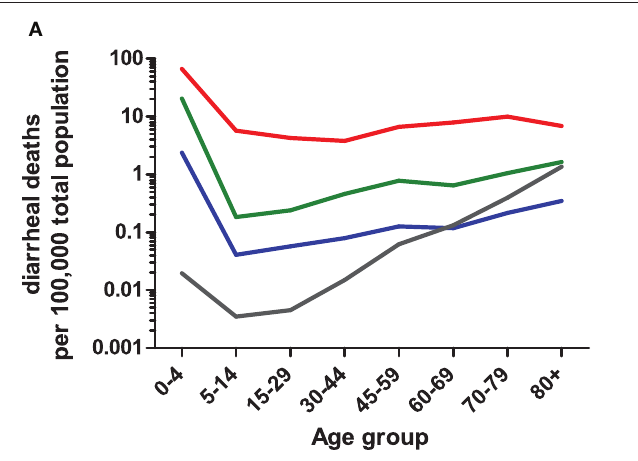
which ( n = 18) are classified as upper-middle income countries and were therefore included in the upper-middle income data. The low-income (red line) category consists of African Region (AFR D and E) and South East Asian Region (SEAR D); low-middle (green line) consists of Region of the Americas (AMR D), Eastern Mediterranean Region (EMR D), Western Pacific Region (WPR B), and SEAR B; upper-middle (blue line) consists of AMR B, EMR B, and European Region (EURB and C); upper (grey line) consists of AMR A, EUR A, and WPR A. The mortality rate data are limited by the use of all-age population data, so actual age-dependentrates may differ.